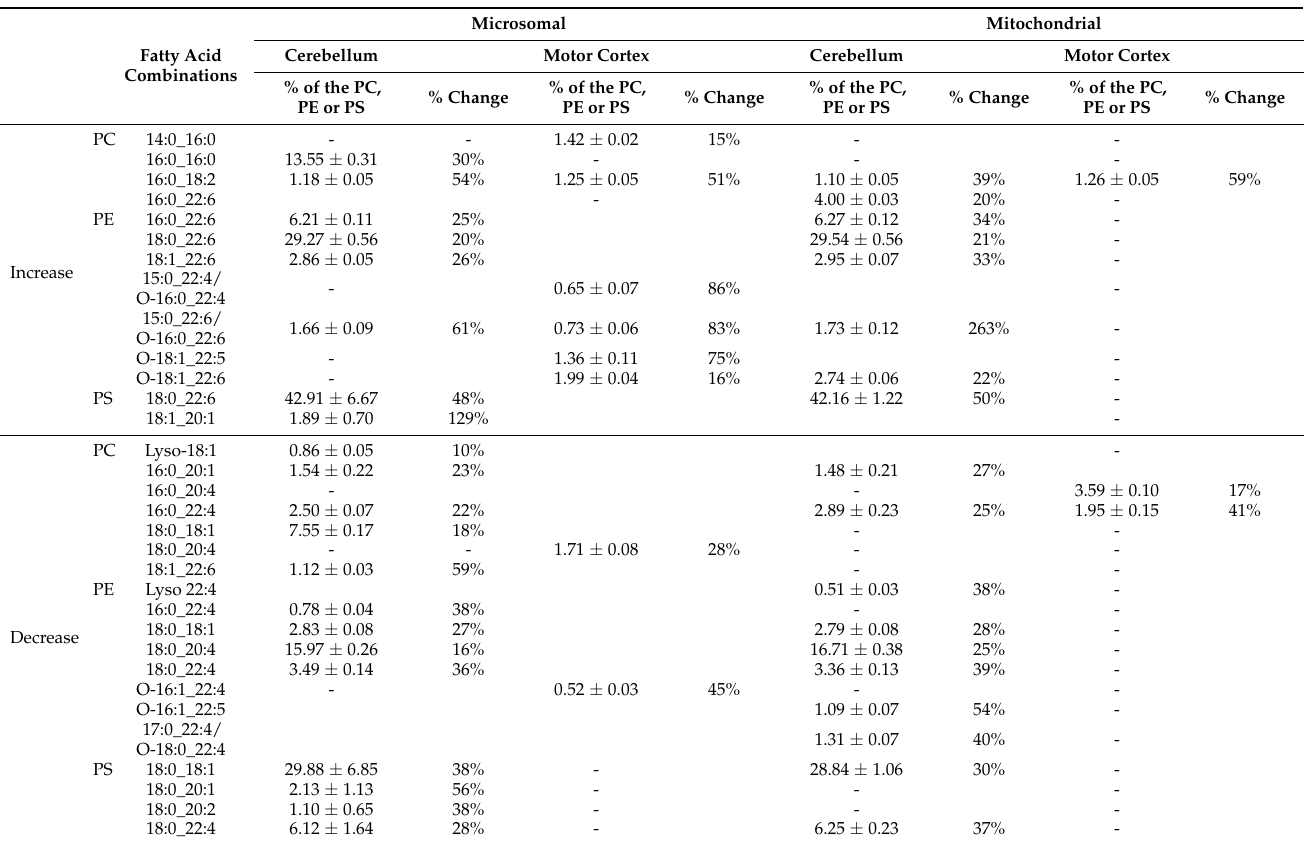
Table 1. The relative abundance (% of the PC, PE or PS) and percentage of change (% change) of the membrane phospholipids that changed in the cerebellum and motor cortex between the ages of 20 and 100 years.